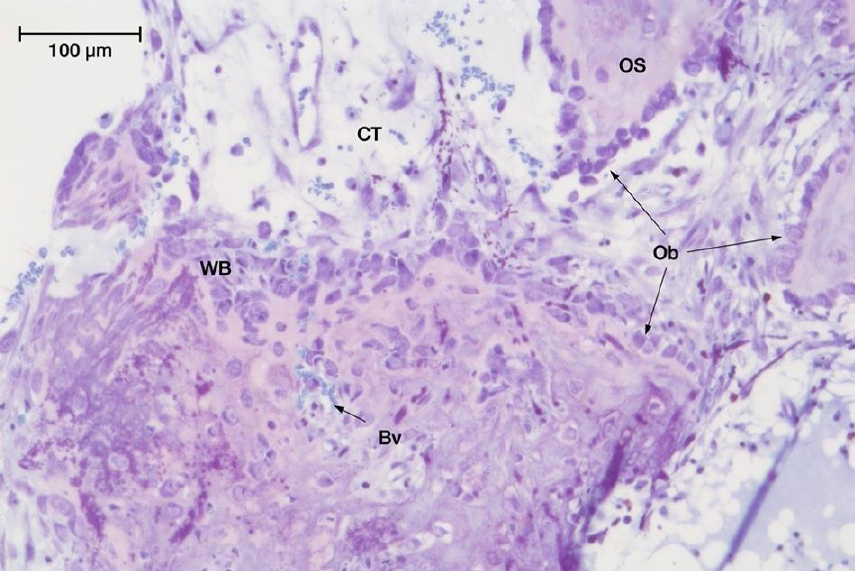
Figure 5. Intense ossification activity observed in minocycline-treated series (test group II) at 8 weeks with toluidine blue staining (original magnification: 20×).